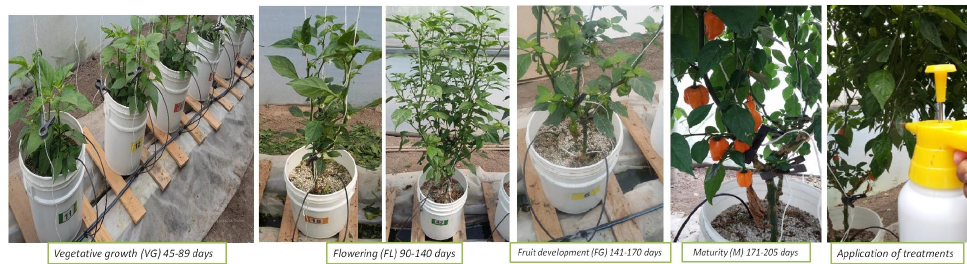
Figure 1. Schematic representation of each of the vegetative stages of the crop, additionally, a representative image of the way in which the treatments were applied is presented.